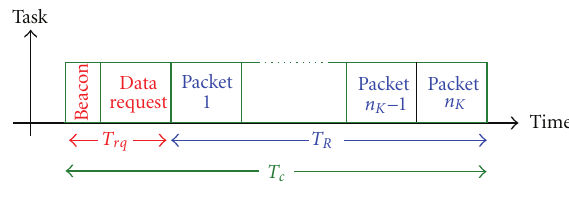
Figure 2: The mobile BS data gathering